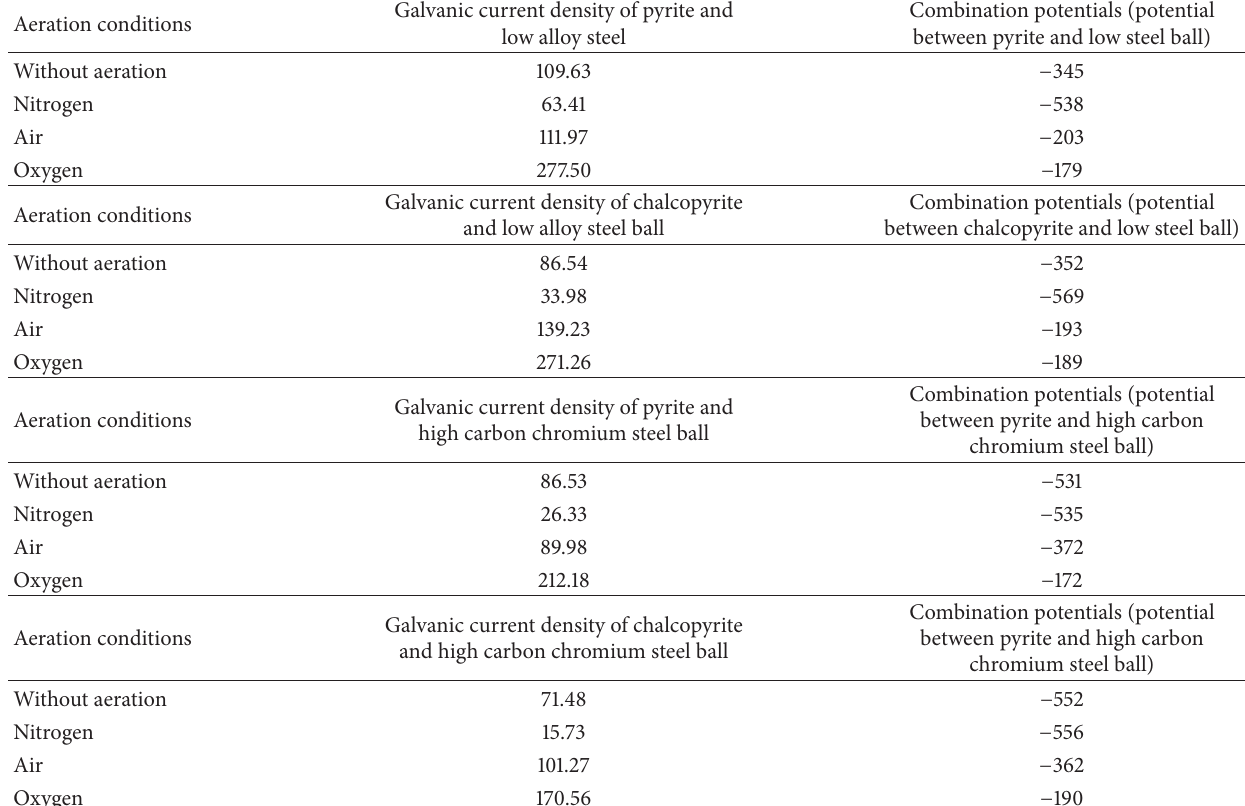
Table 3: The measured galvanic current densities ( 𝜇 A/cm 2 ) and combination potentials (mV) (versus Ag/AgCl (3.0MKCl)) of pyrite, chalcopyrite with low alloy and high carbon chromium steel ball under different aeration conditions in mill.